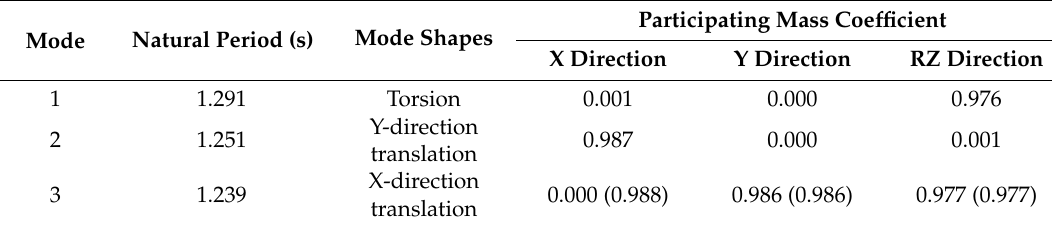
Table 2. Numerical results of dynamic characteristic parameters.